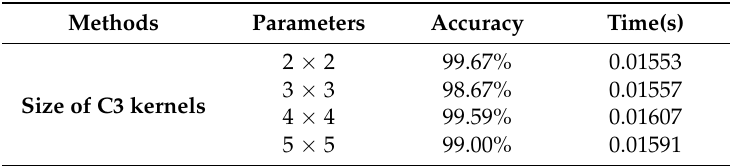
Figure 9. Training and validation curves of LeNet-5 with different sizes of convolutional kernels. Table 6. Comparison of results with different size of convolutional kernels Table 3. Comparison of results with different size of convolutional kernels.